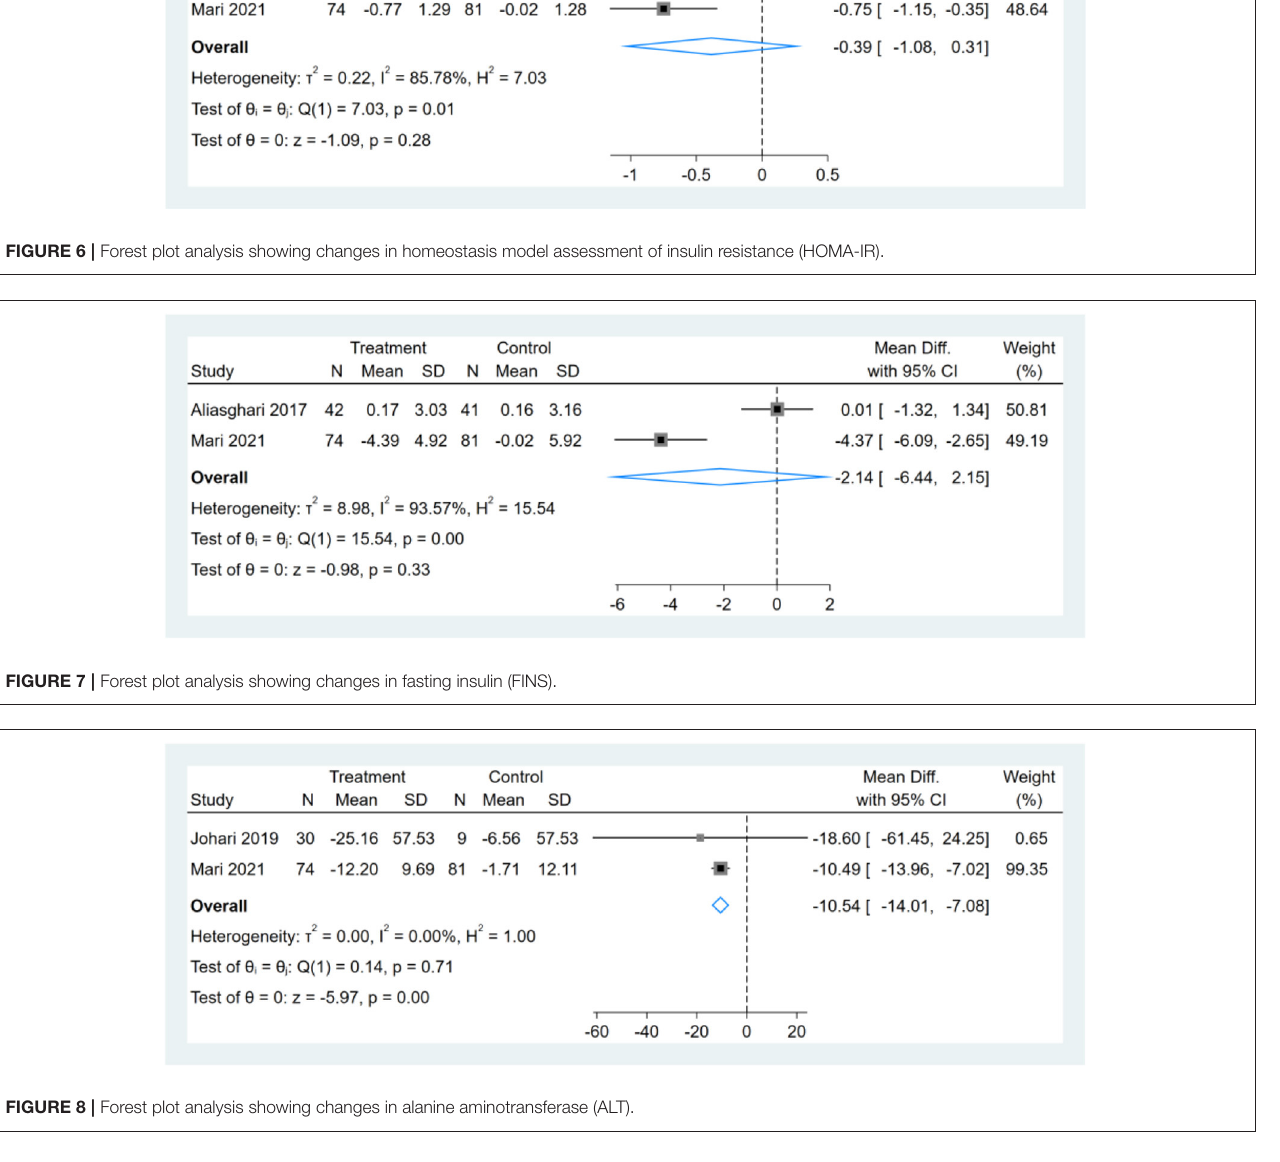
Frontiers in Nutrition |